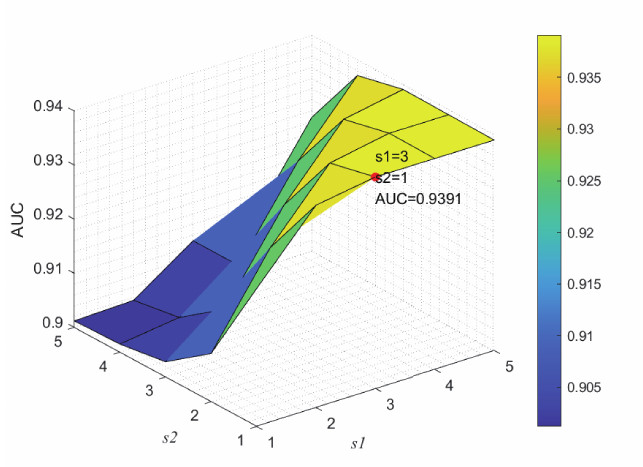
Figure 12. Joint sensitivity analysis of parameters s 1 and s 2 .